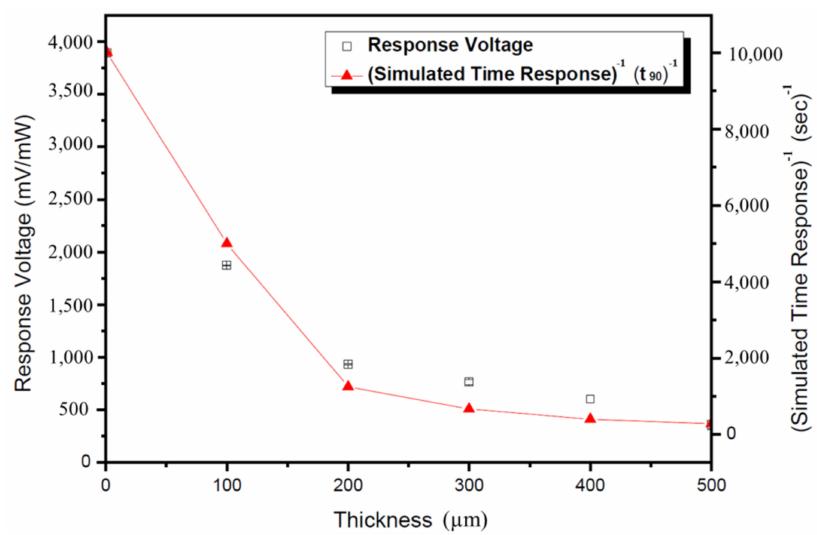
Figure 12. Comparison of experimental voltage response and simulated temperature variation for ZnO sensors with different substrate thicknesses. (Note that the cutoff frequency is 400 Hz in every